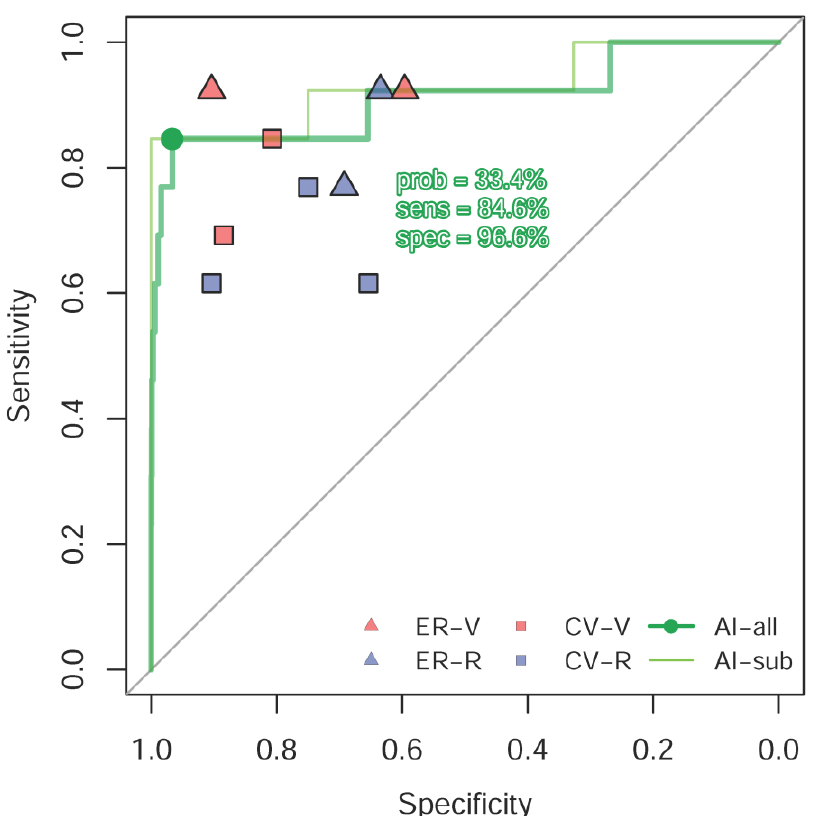
Figure 1. Performance comparison in digoxin toxicity recognition in the human-machine competition. The receiver operating characteristic curves (ROC curves) were made by the predictions of the deep learning model in the validation cohort (AI-all) and the human-machine competition (AI-sub), respectively. The red and blue points represent visiting staff members and residents, respectively. The triangle and square marks represent the emergency physicians and cardiologists, respectively. The areas under curve (AUCs) were 0.912 and 0.929 in the validation cohort and the human-machine competition, respectively. The sensitivity was 84.6%, the specificity was 96.6%, and the probability was 33.4% in the validation cohort. The positive predictive value in the validation cohort was